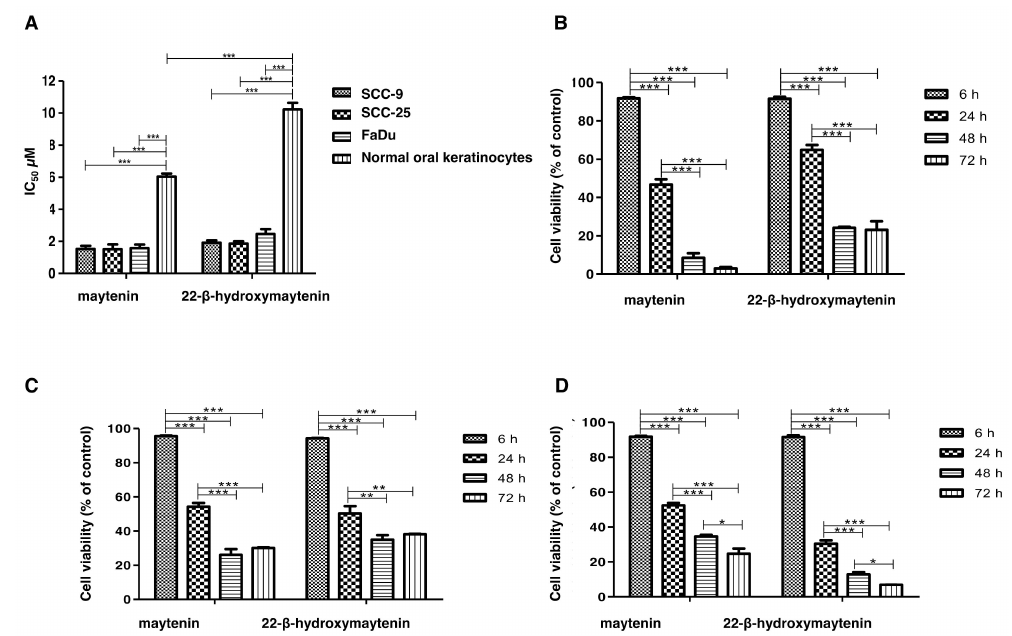
Figure2. CellviabilityresultsfromMTTassayafterincubationwithmayteninor22- β -hydroxymaytenin.